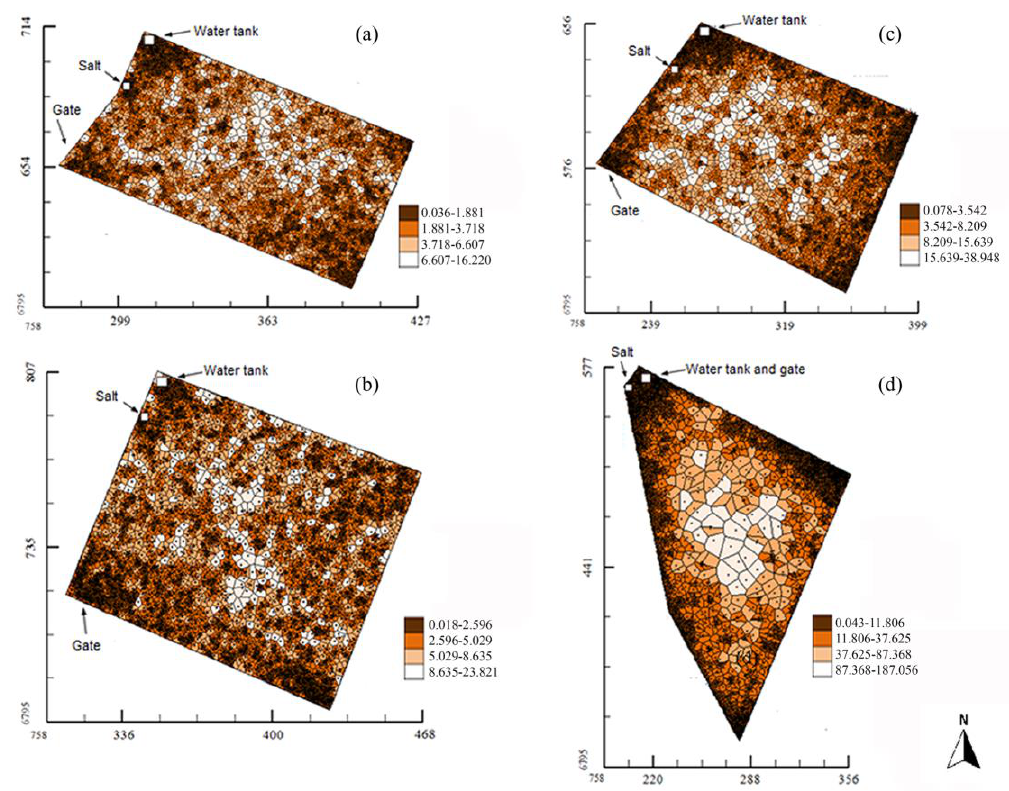
Figure 2. Cumulative spatial distribution of dung patches at different grazing intensities. Sward heights of ( a ) 0.1 m, ( b ) 0.2 m, ( c ) 0.3 m and ( d ) 0.4 m on mixed black oat ( Avena strigosa Schreb.) and Italian ryegrass ( Lolium multiflorum Lam.) pastures at the end of the stocking period of an integrated soybean-beef cattle system in southern Brazil. The smaller/darker the polygons, the higher the dung density. Arrows indicate watering and salt feeding sites as well as paddock gates.